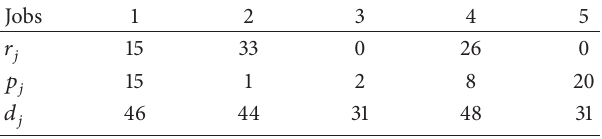
Table 2: Data of the 5-job instance of Example 1. Jobs